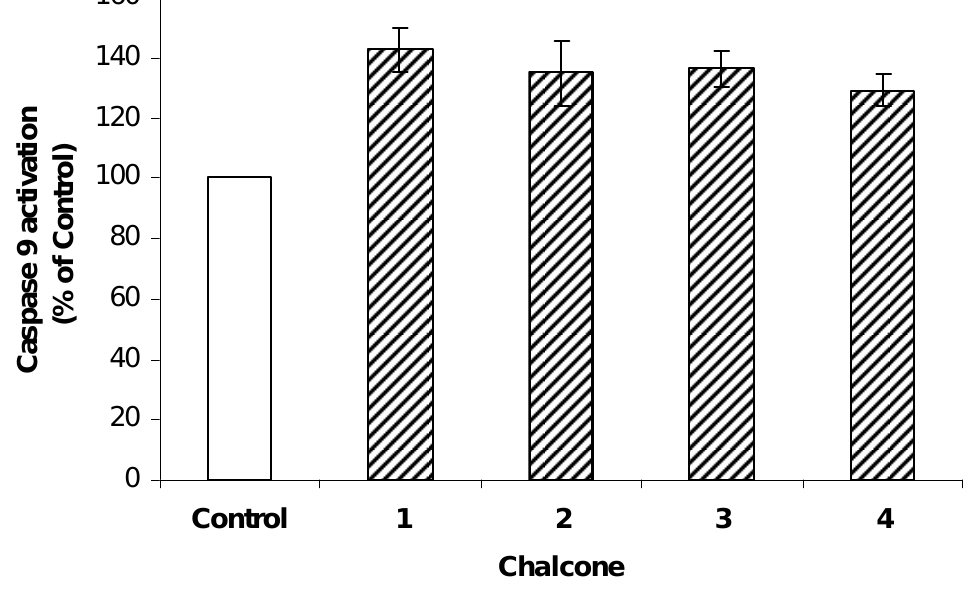
Figure 5. Chalcones induces activation of caspase-9. HepG2 cells treated with chalcone (200 µM) were analyzed for caspase activity after 24 h incubation. The results of studies are expressed as mean values ±SD from four separate experiments